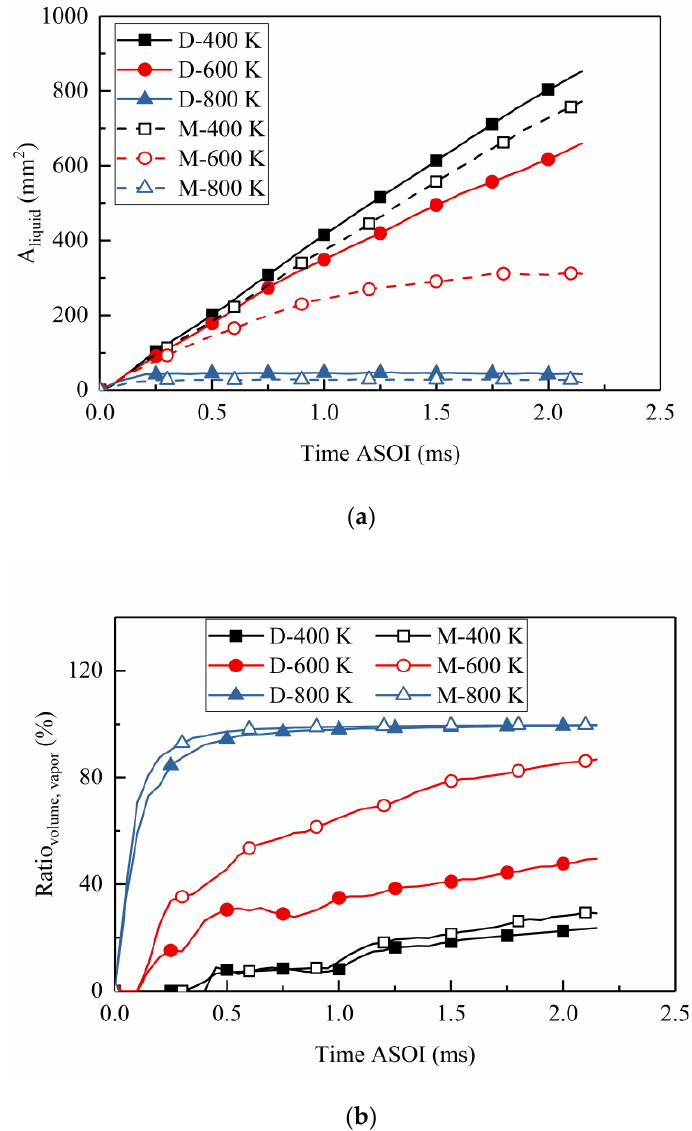
Figure 9. Comparison results of the evaporating characteristics of methanol and diesel spray under different ambient temperature conditions. ( a ) Results of the liquid phase spray tip penetration. ( b ) Volume fraction of the vapor phase.